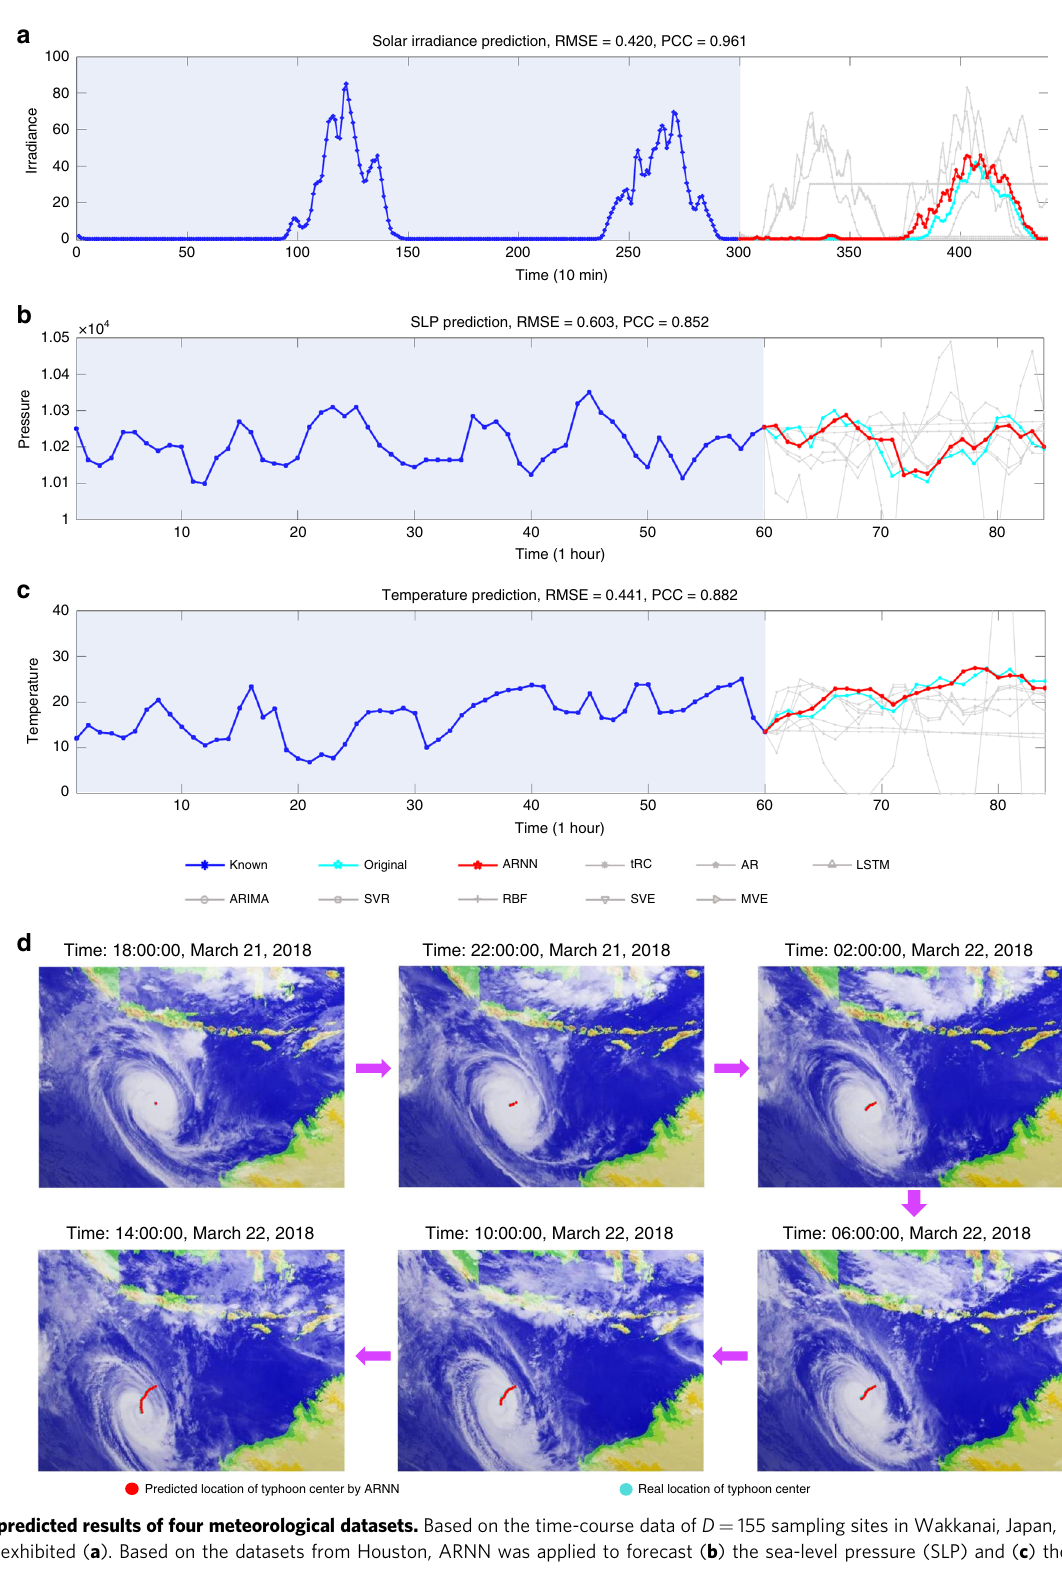
Fig. 4 The predicted results of four meteorological datasets. Based on the time-course data of D = 155 sampling sites in Wakkanai, Japan, the prediction results are exhibited ( a ). Based on the datasets from Houston, ARNN was applied to forecast ( b ) the sea-level pressure (SLP) and ( c ) the average temperature of the sea. The performance of ARNN is better than that of the other prediction methods. d Based on the satellite cloud images of tropical cyclone Marcus (March 2018) collected by the National Institute of Informatics, ARNN predicted the locations of the typhoon center (http://agora.ex.nii. ac.jp/digital-typhoon/). The known information included the initial m = 50 images, based on which ARNN outputted L − 1 = 21 future locations of the typhoon